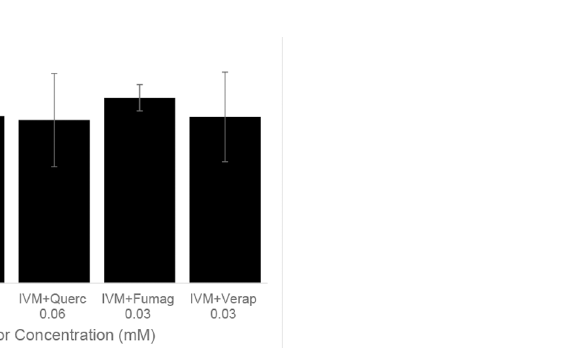
Fig 2. Mean 24 h mortality ( ± SE) of honey bees fed 1 μ g/ml ivermectin treated with low concentrations of inhibitors. Bees fed Pristine (Prist), quercetin (Querc), fumagillin (Fumag) and verapamil (Verap) in sucrose syrup. All inhibitor/doses shown had significantly greater mortality than the ivermectin-only control (P < 0.002).